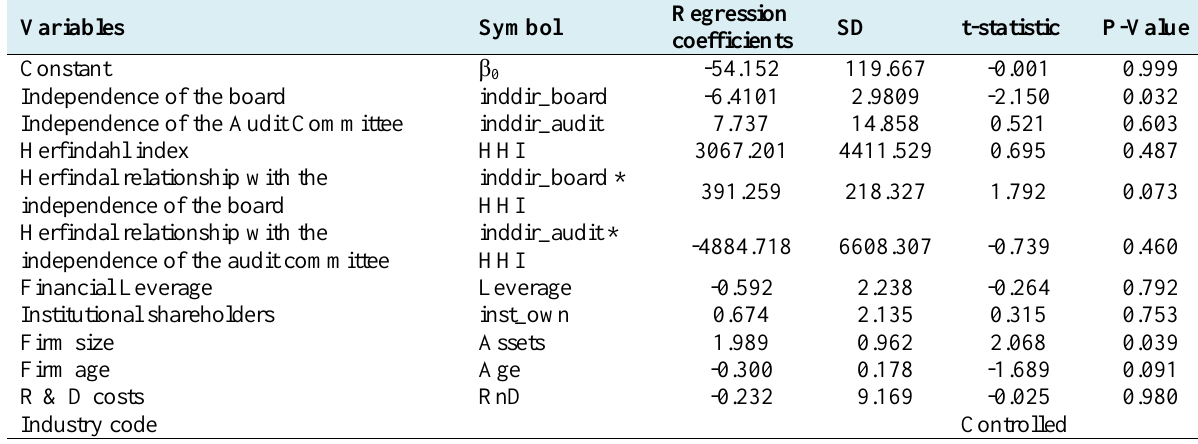
Table 7. Results of fitting the model related to the third criterion of opinion shopping (simultaneous increase of audit fee and increase of the amount of restatement in the current year compared to that in the previous